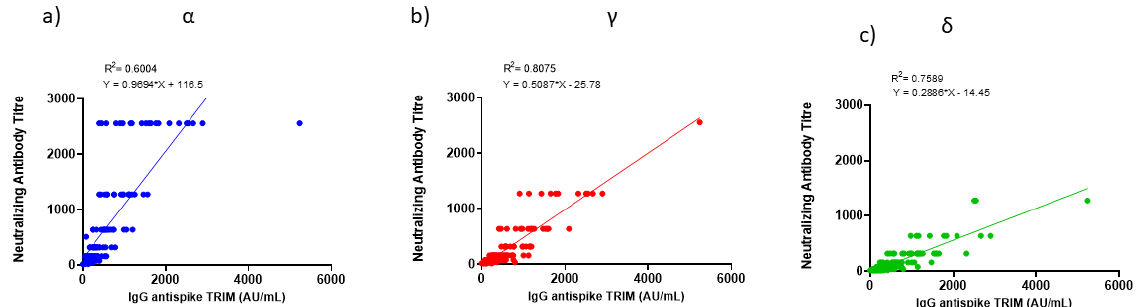
Figure 4. Correlation between neutralizing antibody titres against variants of interest and IgG anti- spike TRIM levels ( a ) correlation between neutralizing antibody titres against Alpha variants and IgG anti-spike TRIM levels; ( b ) correlation between neutralizing antibody titres against Gamma variants and IgG anti-spike TRIM levels; ( c ) correlation between neutralizing antibody titres against Delta variants and IgG anti-spike TRIM levels.